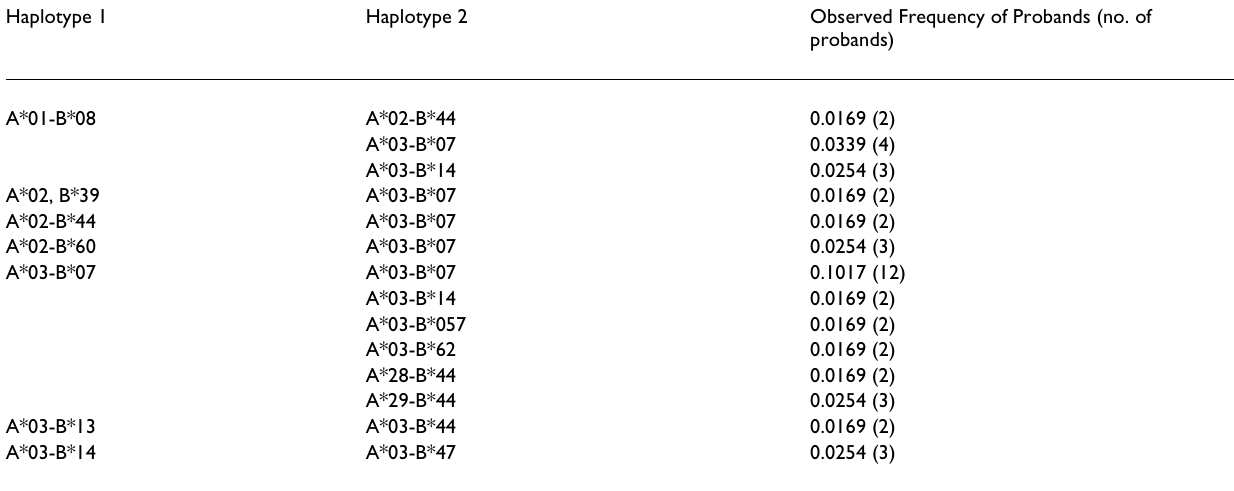
Table 4: HLA Haploidentical Alabama Hemochromatosis Probands. 1 Haplotype 1 Haplotype 2 Observed Frequency of Probands (no. of